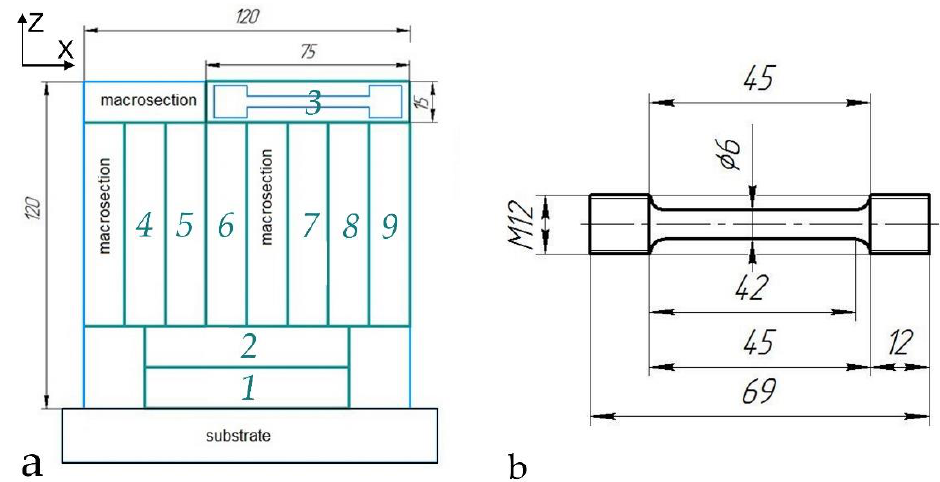
Figure 4. Plan of sampling sites for examination and a scheme for cutting out samples for mechanical tests ( a ) and the drawing of the tensile specimen in millimeters ( b ).